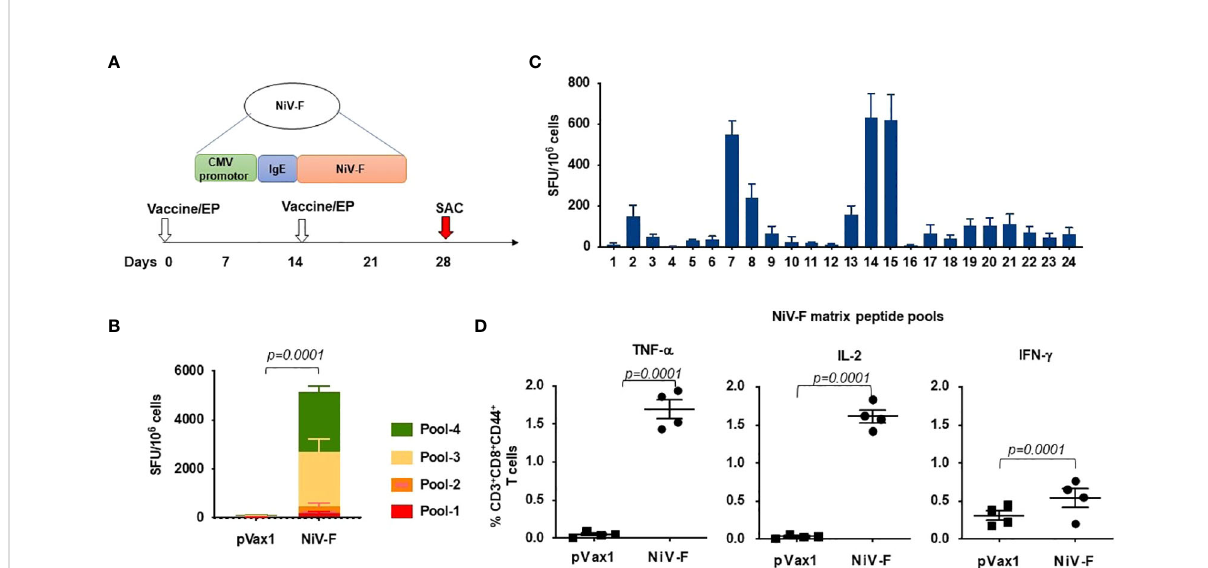
FIGURE 4 Functional pro fi le of cellular immune responses elicited by NiV-F vaccine in mice. (A) Schematic representation of different time points of EP mediated immunization and immune analysis of this study. C57BL/6 mice (n=4 per group) were immunized with 25 m g of NiV-F vaccine using EP mediated enhanced delivery. (B) Immunization of mice with NiV-F vaccine induced robust CD8 + T cell responses. Nipah-speci fi c CD8 + T- lymphocyte responses were assessed by IFN- g ELISpot assay to each of 4 pools of linear overlapping peptides spanning the whole NiV-F. Data represents the responses Mean±SD in each group one week after the second immunization. (C) Characterization of NiV-speci fi c dominant epitopes in C57BL/6 mice. IFN- g responses were assessed by ELISpot assays with matrix pools of peptides, indicating the presence of immunodominant epitopes comprising of the NiV-F. Values represent mean responses in each group ( n=4 ) ± SEM. (D) Immunization with NiV-F vaccine induced a higher number of activated CD8 + T cells capable of producing IFN- g , TNF- a and IL-2 when stimulated by Nipah-F peptides. One week after the last immunization with the NiV-F vaccine, splenocytes were cultured in the presence of pooled NiV-F peptides or RPMI media + 10% FBS (R10) only. Flow cytometry measured the frequency of NiV-F -speci fi c IFN- g , TNF- a and IL-2 secreting CD8 + T cells. Single function gates were set based on negative control (unstimulated) and were placed consistently across the samples. The percentage of the total CD8 + T-cell responses are shown. These data are representative of two independent immunization